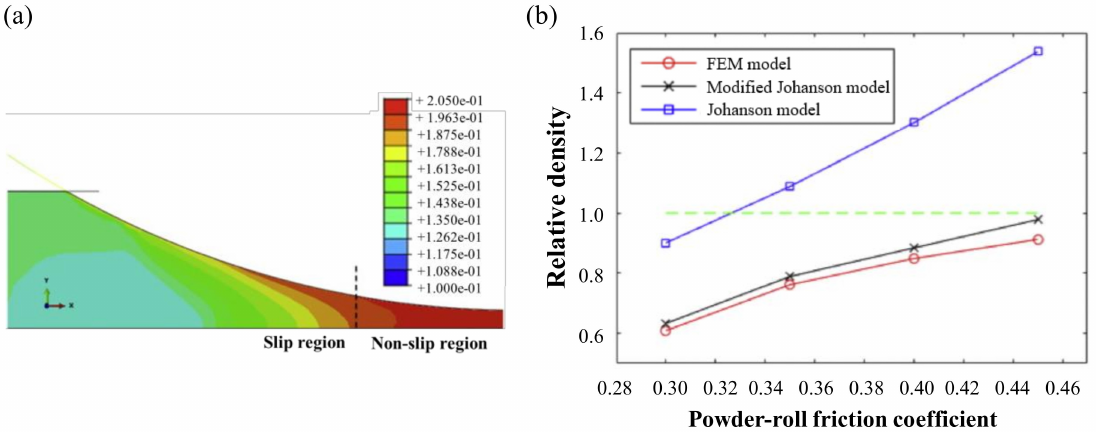
Figure 18. ( a ) Material velocity field using a finite element method (FEM) simulation, the dashed-line indicates the location of nip angle in Johanson’s model; ( b ) relative density as functions of powder-roll friction coe ffi cient at three models; FEM, modified Johanson and Johanson model [18]. The figures were slightly modified, with permission from